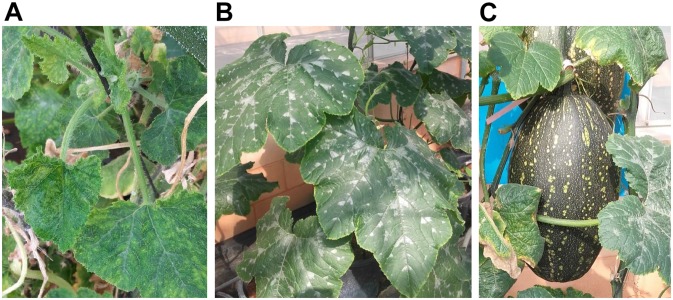
Plants of the interspecific F1 resulting from the cross C. pepo MU-CU-16 × C. moschata PI 604506. (A) Typical symptoms of tomato leaf curl New Delhi virus including curling, severe mosaic, and short internodes. (B) Healthy plant used to obtain F2 progeny by selfing in a greenhouse. (C) Detail of F1 (MU-CU-16 × PI 604506) fruit obtained by selfing.